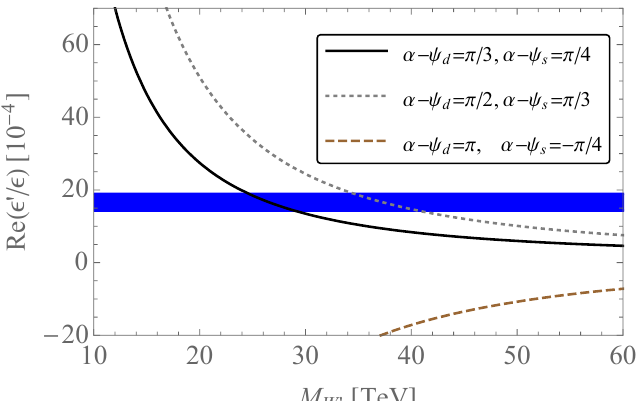
Figure 1 . Numerical result of Re( (cid:15) 0 =(cid:15) ). The blue band represents the 1 (cid:27) range of experimental data given by PDG [8], while model predictions with speci(cid:12)c choice of phases are shown by the lines.